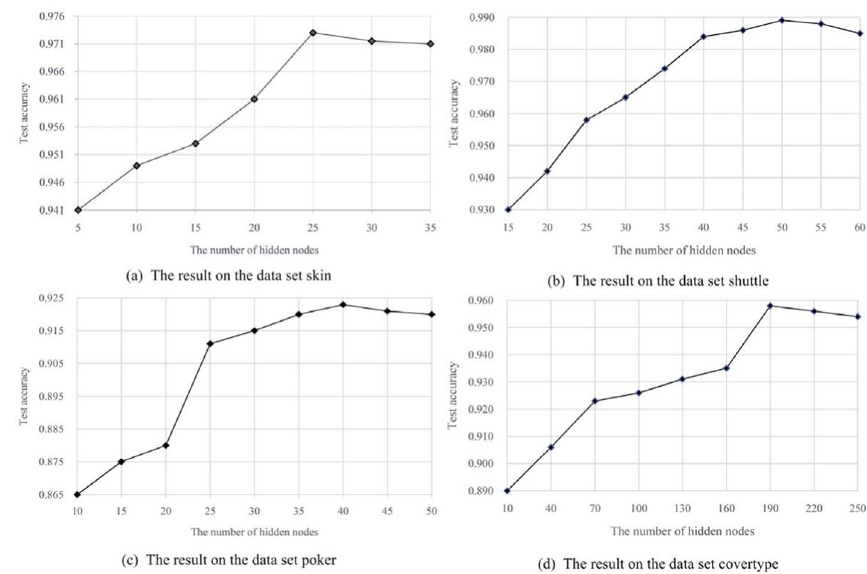
Fig. 6 The relationship between the number of hidden layer nodes and test accuracy